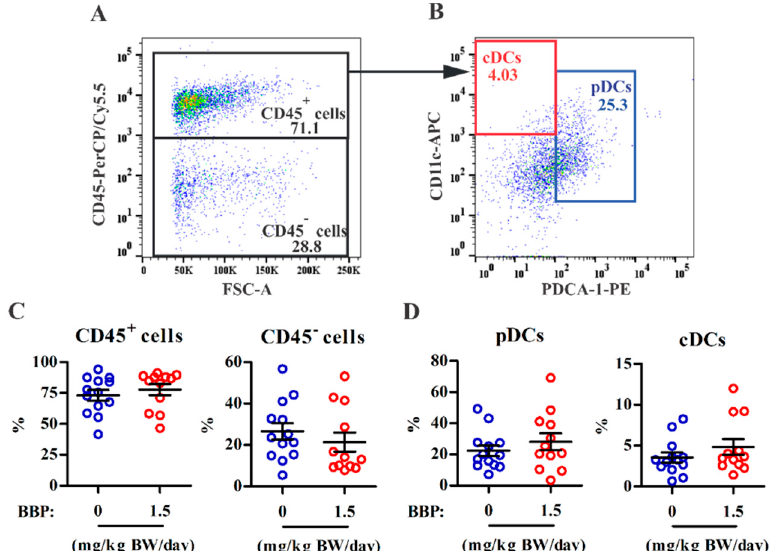
Figure 2. The effect of BBP on immune cell infiltration in endometriotic lesions. Endometriotic lesions were pooled from each single mouse for the analysis of immune cell subsets using multiparametric flow cytometry. ( A ) Representative dot plots are shown for gating for CD45 + (immune) cells and CD45 − (nonimmune) cells among viable cells and ( B ) gating for plasmacytoid dendritic cells (pDCs) (PDCA-1 + CD11c low ) and conventional dendritic cells (cDCs) (PDCA-1 − CD11c + ) among CD45 + cells in lesions. ( C , D ) The percentages of CD45 + cells and CD45 − cells ( C ) and pDCs and cDCs among the CD45 + cells ( D ) in pooled lesions from each mouse ( n = 12 or 13 mice/group from four independent experiments). Each data point represents data from one mouse. The horizontal lines and error bars represent the mean and SEM, respectively, for each group.